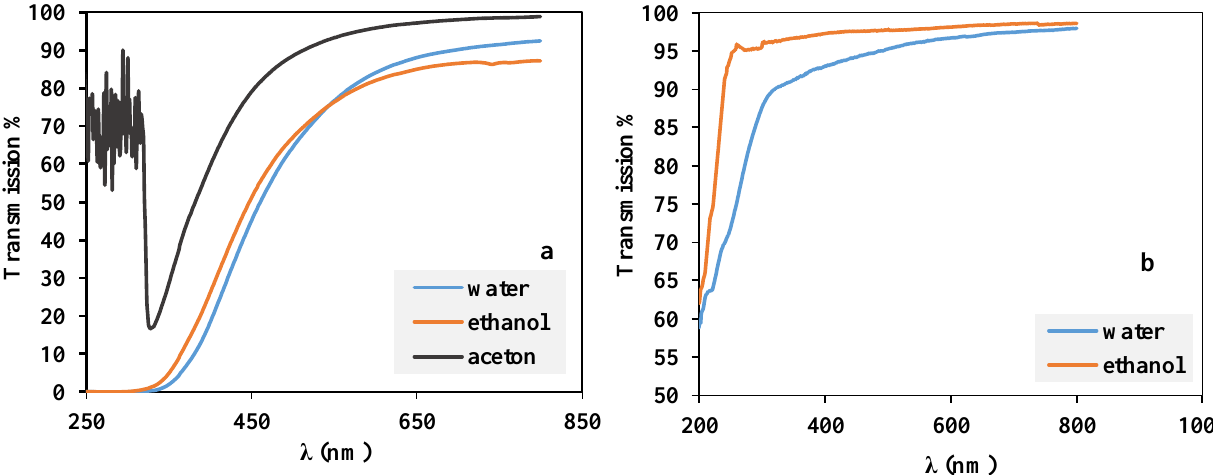
Figure 2: Transmission spectra of lithium-niobate suspension (a) LN pellet, (b) LN wafer.